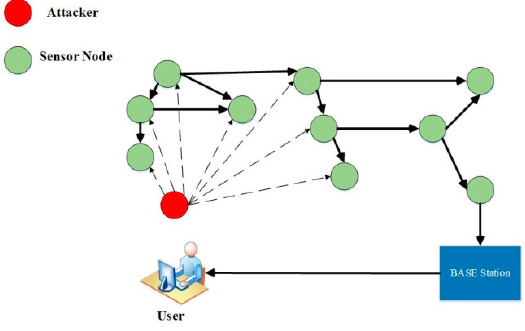
Figure 18. Hello flood attack on WSN [91].